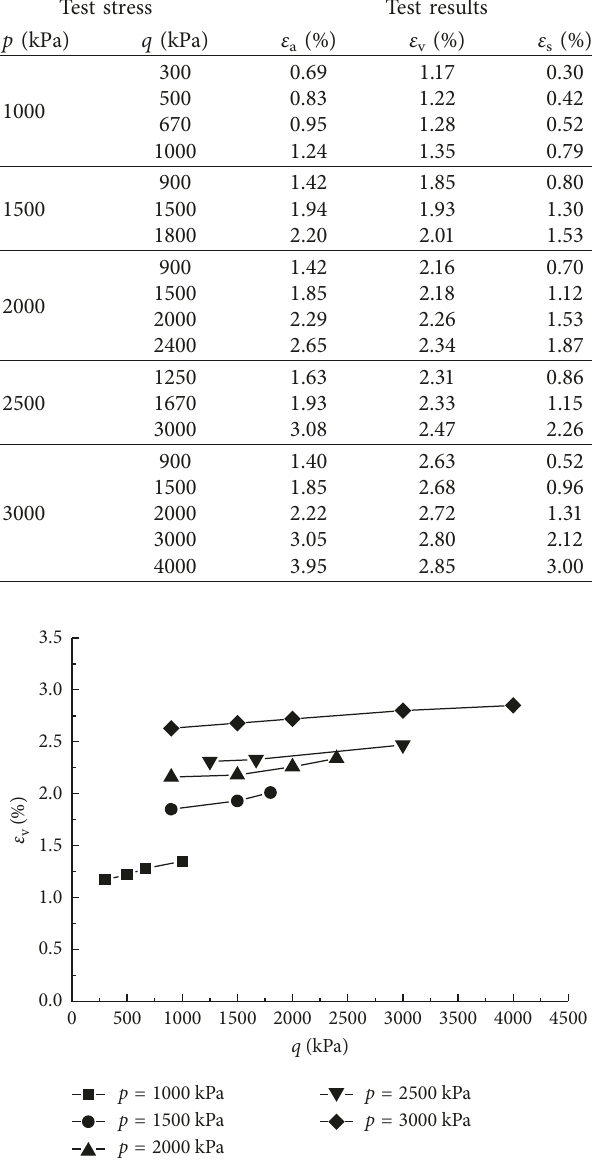
Figure 3: q versus ε v curve (stress conditions of equal p and unequal q